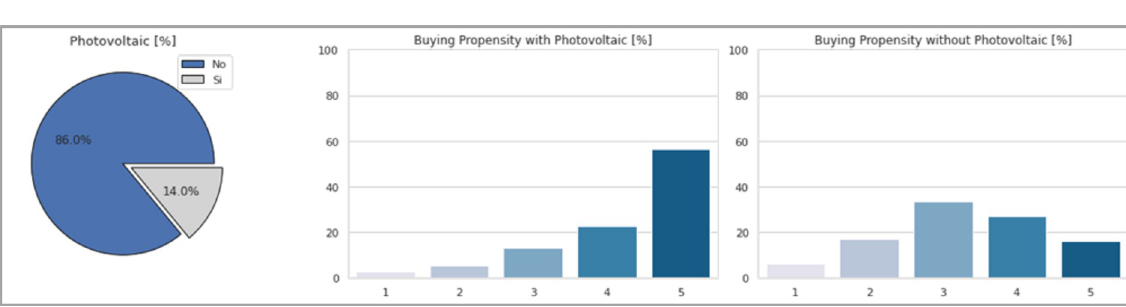
Fig 9. Respondents’ opinion towards photovoltaic panels. Starting from the left, it shows how many respondents own at least a Photovoltaic Panel , their Buying Propension with and without it .